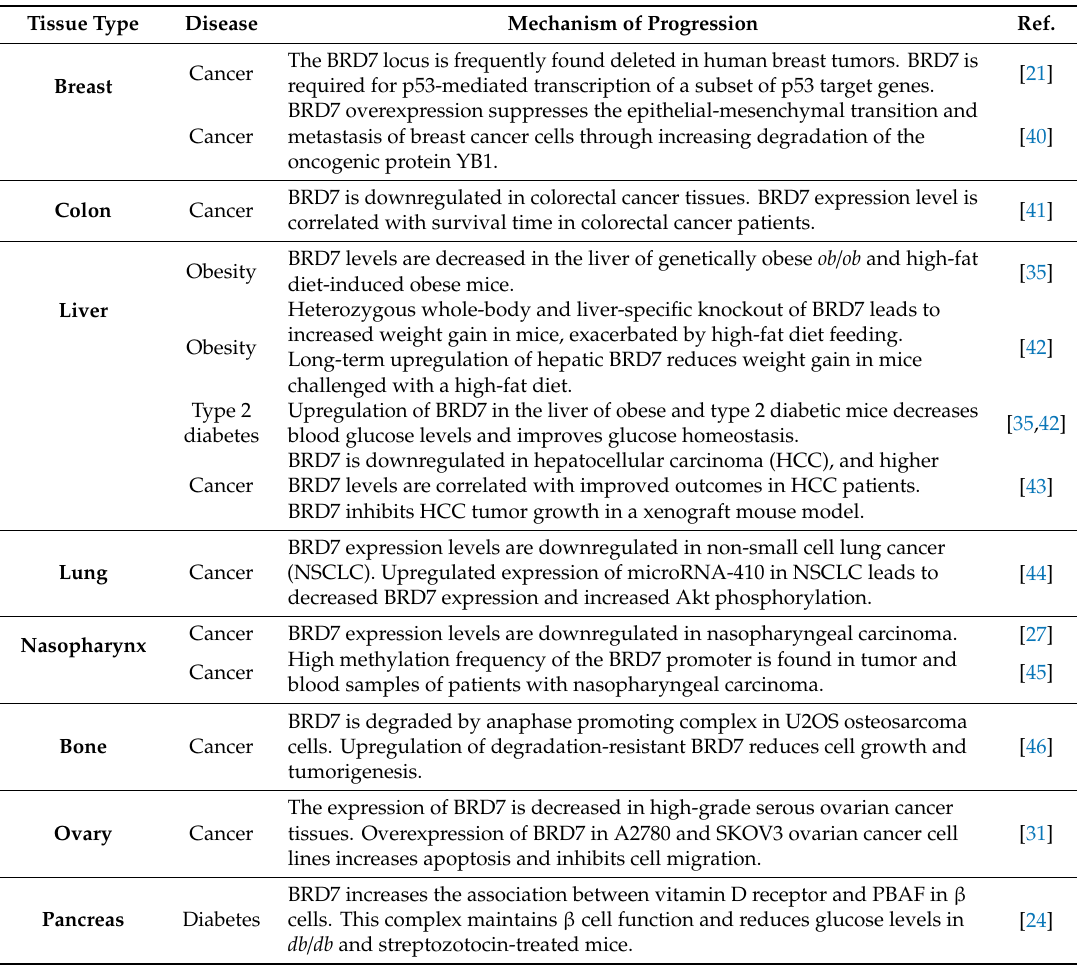
Table 2. BRD7 and pathophysiology in various tissues. The role of BRD7 in diseases of various tissues is